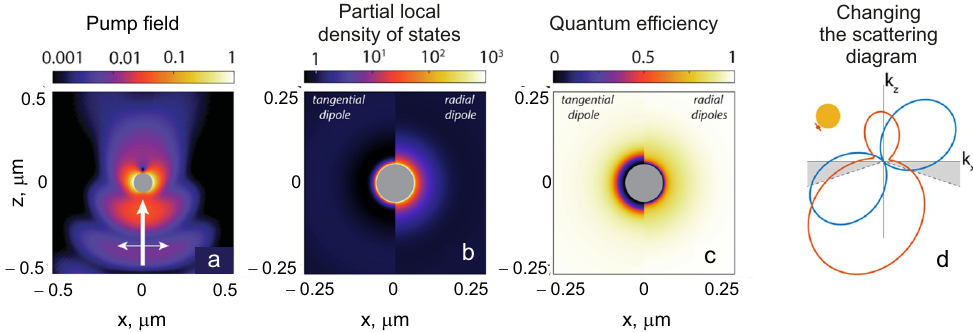
Figure 4. An example of a 100 nm gold Mie sphere in water that is excited by a narrow (NA = 1.3) laser beam at a wavelength of 567 nm, with the emission of the sphere occurring at a wavelength of 600 nm. ( a ) The pump field distribution (first term in (16)) for a wave that is incident from below and is polarized along the x -axis. ( b ) The partial local density of states near the same Mie sphere (at a radiation wavelength of 600 nm) is strongly enhanced on the metal surface, especially for radial transition dipole moments. ( c ) Quantum efficiency (second term in (16)) of the radiation under the condition that the internal efficiency of the QE strongly decreases in a shell around the metal with a radius of 10 nm. ( d ) Examples of the radiation redistributions in this case for a QE (at the top of the sketch), almost on the surface of the sphere and at a distance of 10 nm from the sphere, into the xz -plane (arbitrary geometry). Polar diagram for a free QE (blue curve) and a QE near the sphere (orange curve). The gray shaded area defines the typical acceptance cone of a high NA objective lens. Depending on the geometry, the collection probability can vary greatly (third term in (16)). The figure was taken from